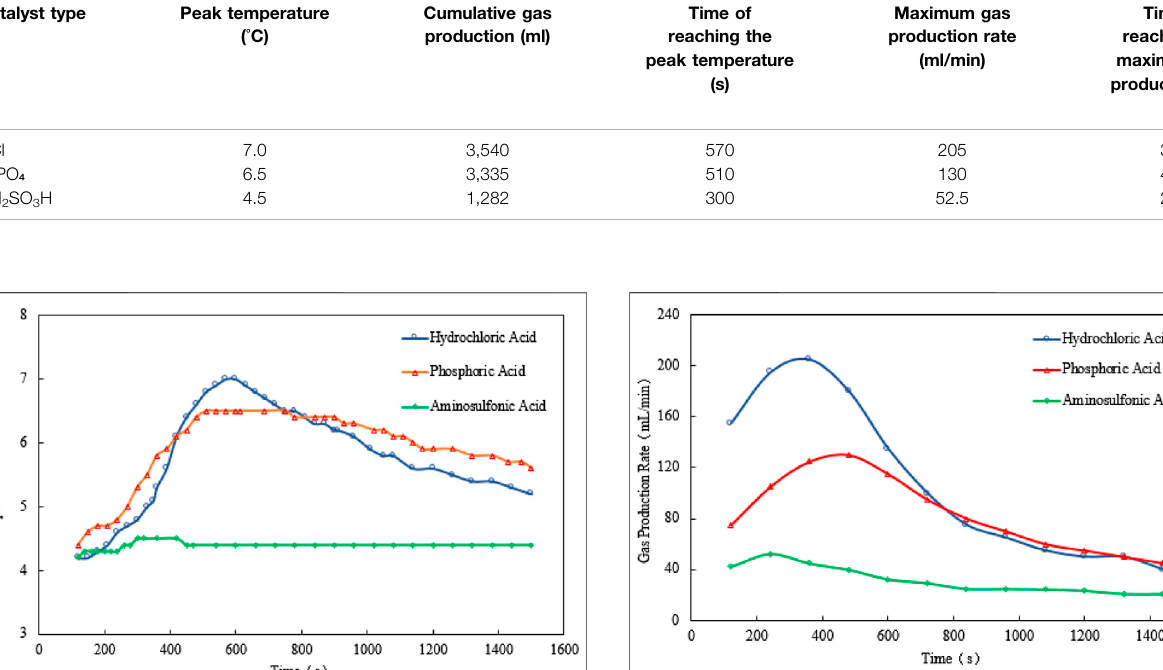
TABLE 2 | Experimental results of scenario 1 Catalyst type